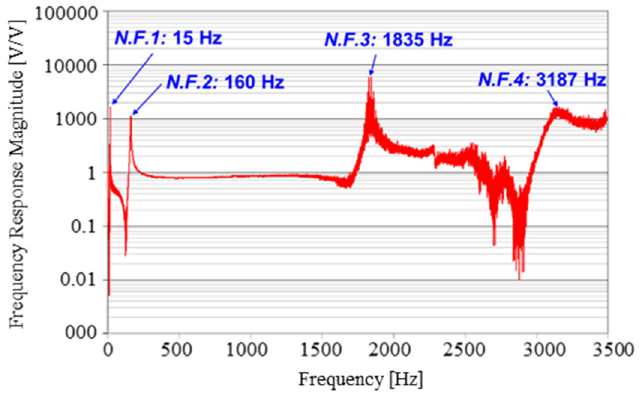
Figure 7. Measured frequency response function of a dual-rotor.